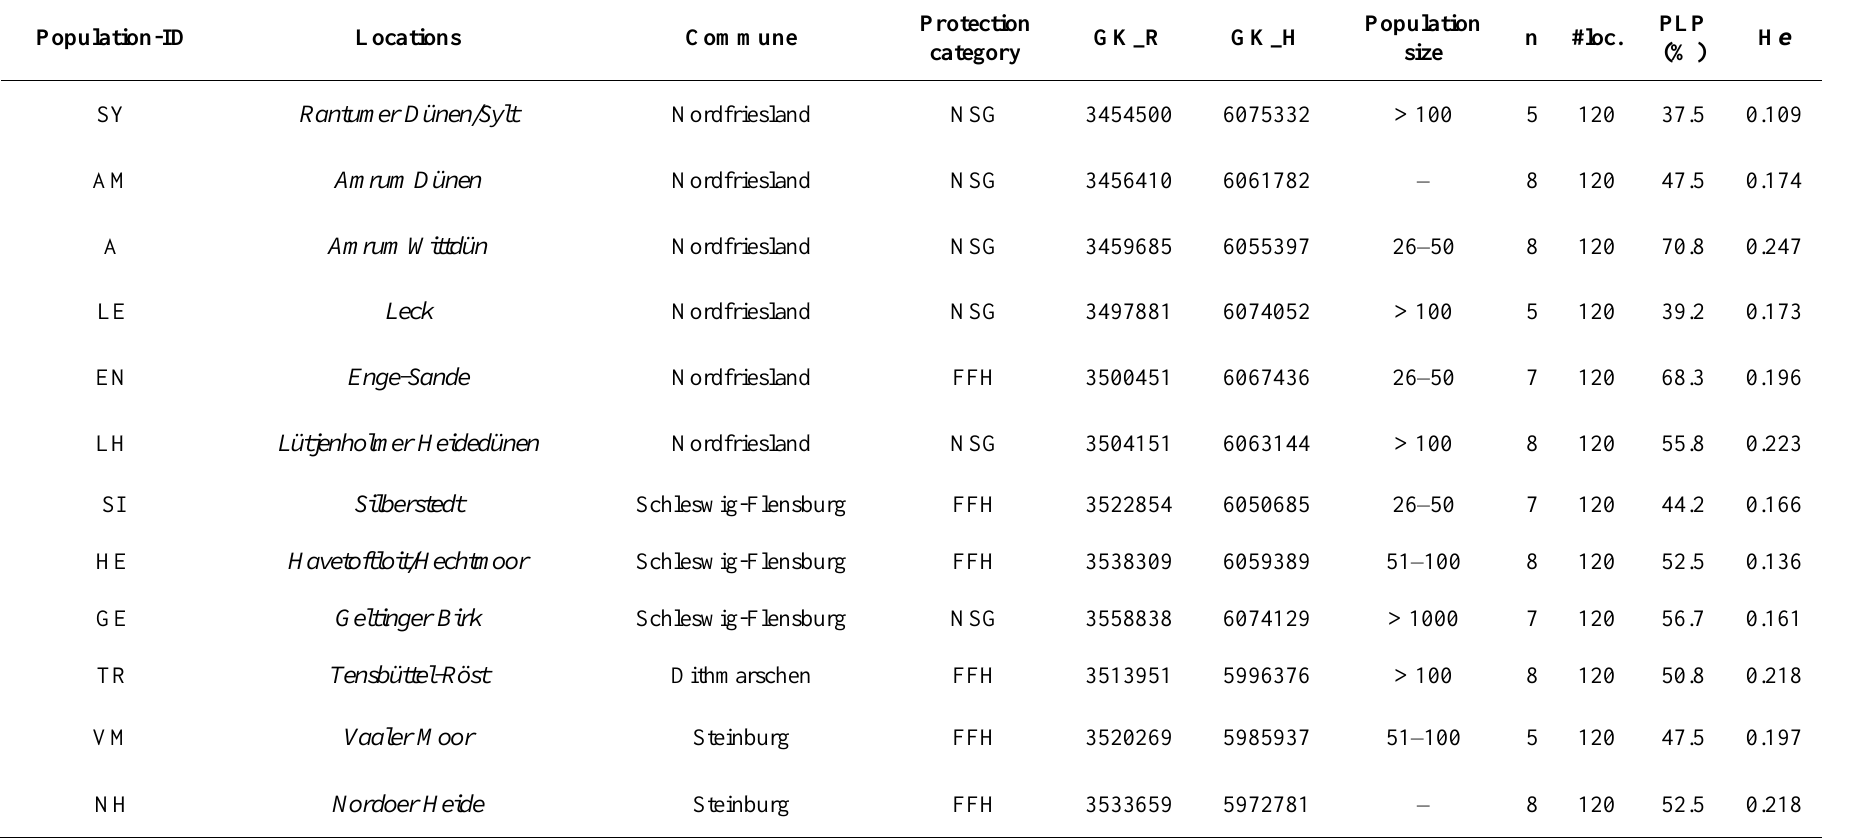
Table 1. Overview of sampled Drosera rotundifolia populations in Schleswig-Holstein, protection category: nature reserve (NSG) Flora-Fauna-Habitat (FFH), Gauss- Krueger coordinates (GK_R; GK_H), estimated population size (- no data available), number of analysed individuals (n), sum of loci (#loc.), percentage of polymorphic loci (PLP) and Nei´s gene Diversity (H e ) after Lynch & Milligan